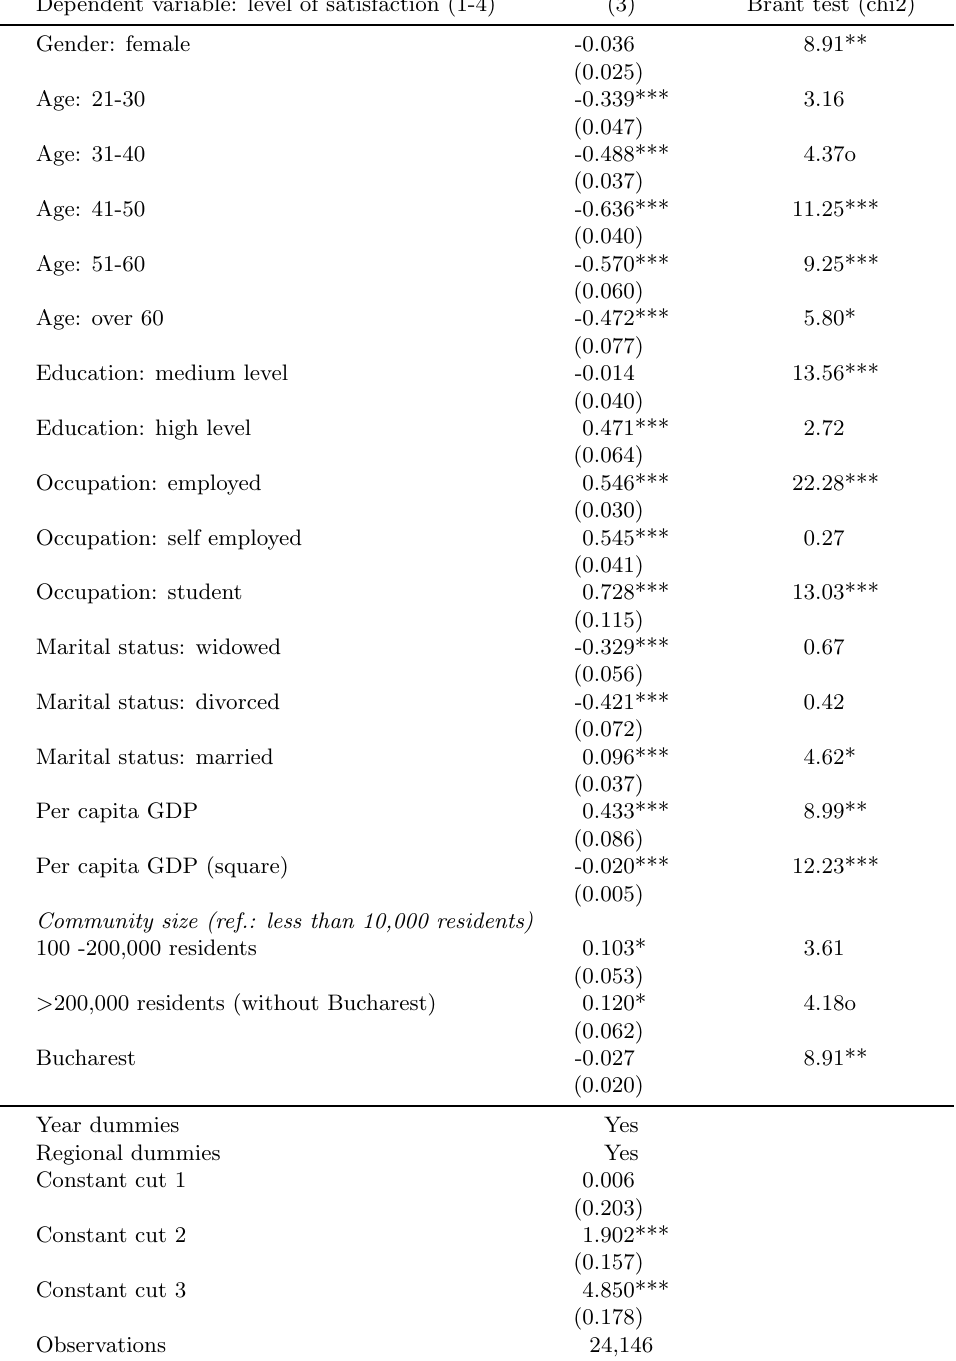
Table A.1: Life satisfaction, individual and regional characteristics: ordered logit